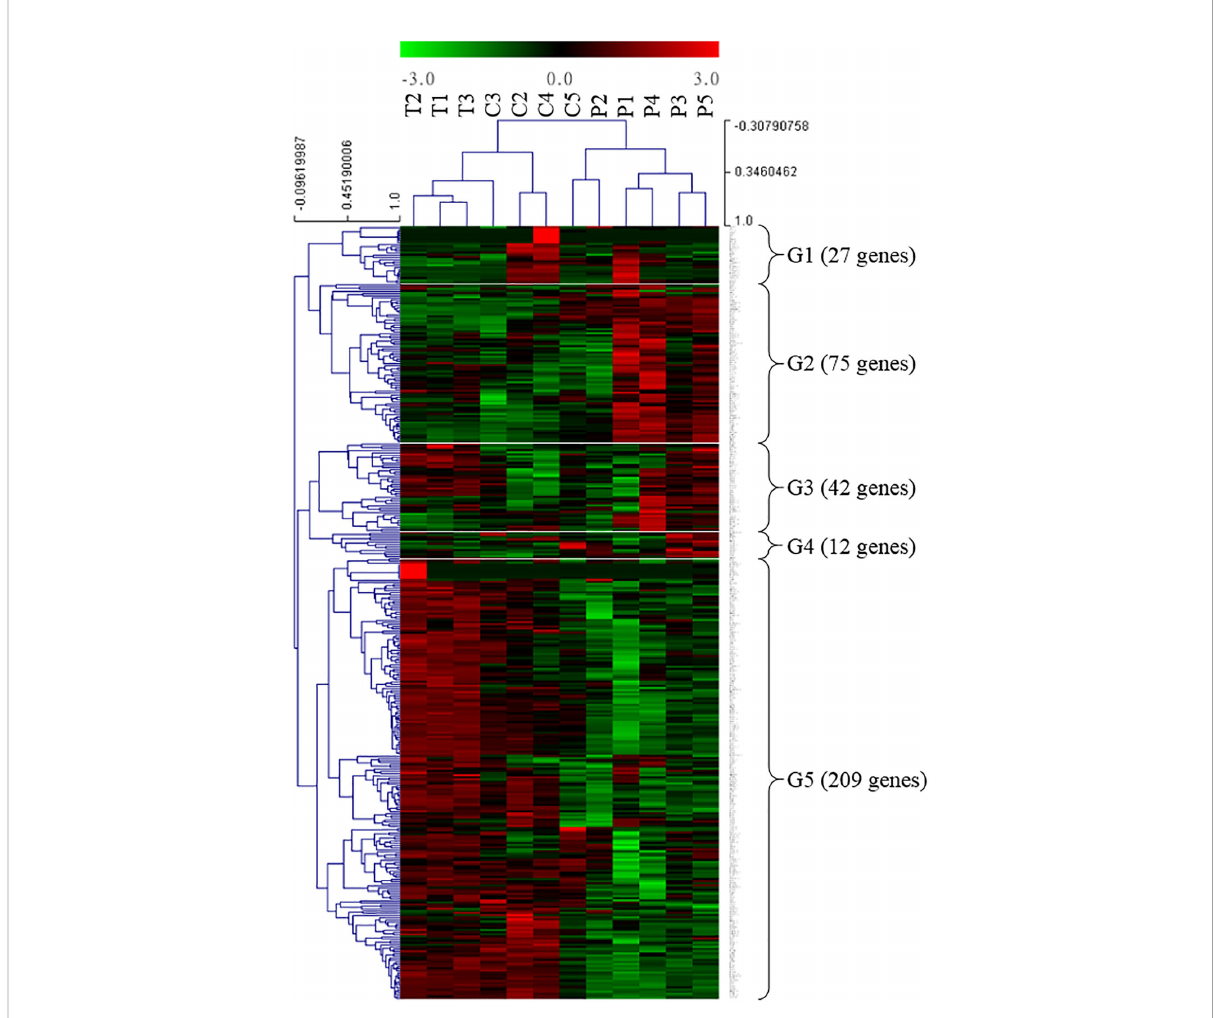
FIGURE 7 Transcriptomic levels of immune-related genes in different ANG stages. Heatmap for cluster analysis of the immune-related genes by hierarchical clustering of Pearson correlation with the Trimmed Means of M values. According to the gene expression, these DEGs were divided into fi ve groups. Green and red indicate downregulated and upregulated genes, respectively. G, group; T, transmission; C, colonization; P,